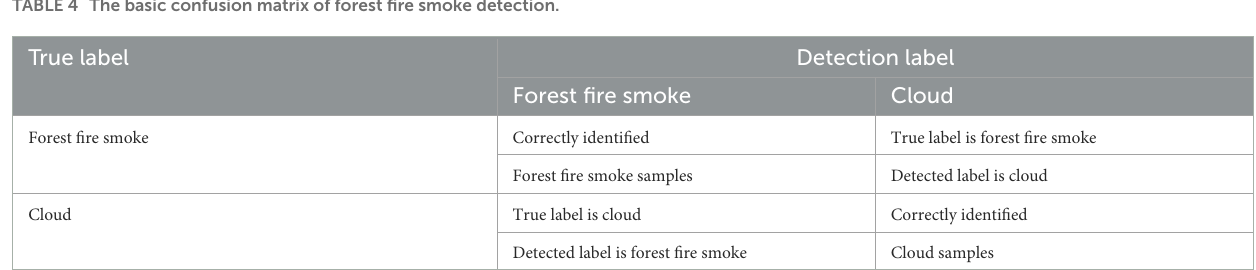
TABLE 4 The basic confusion matrix of forest fire smoke